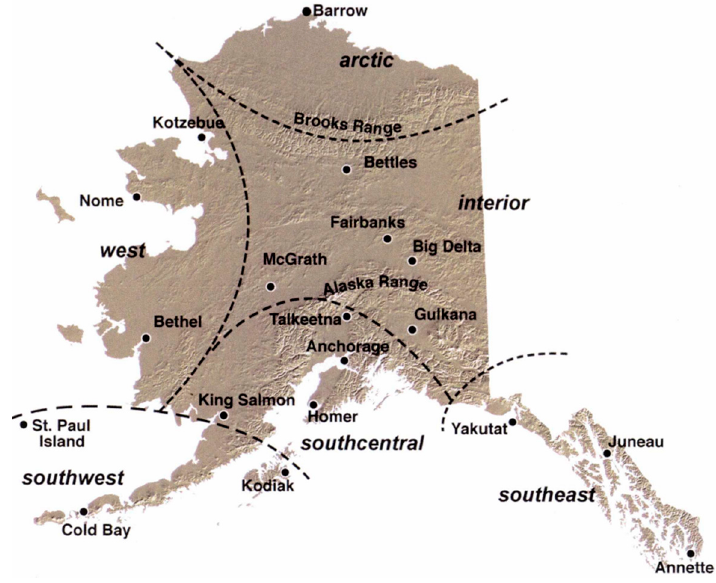
Figure 2. Location of the first-order stations and climatic zones of Alaska from Hartmann and Wendler [17].